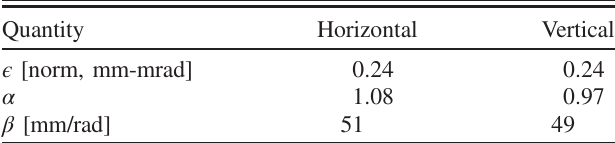
TABLE I. 100% rms parameters of the realistic LEBT distri- bution at the entrance to the RFQ. Horizontal